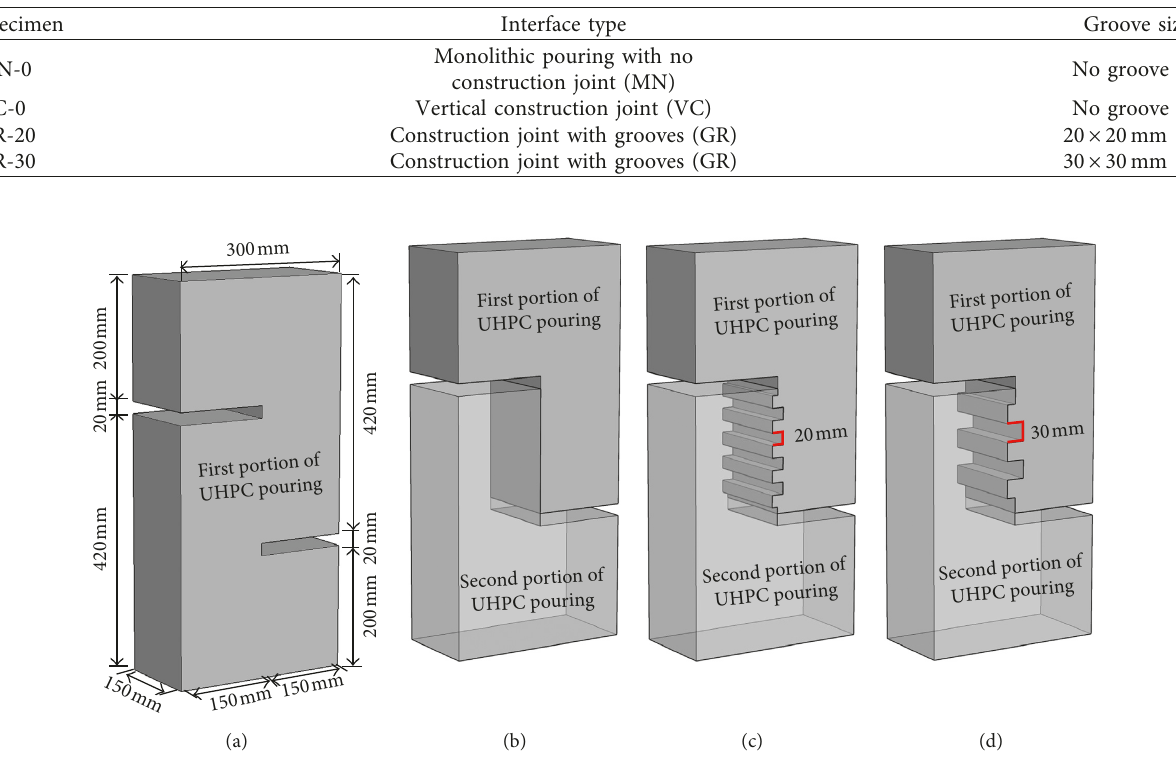
Table 1: Characteristics of the UHPC construction joint specimens.